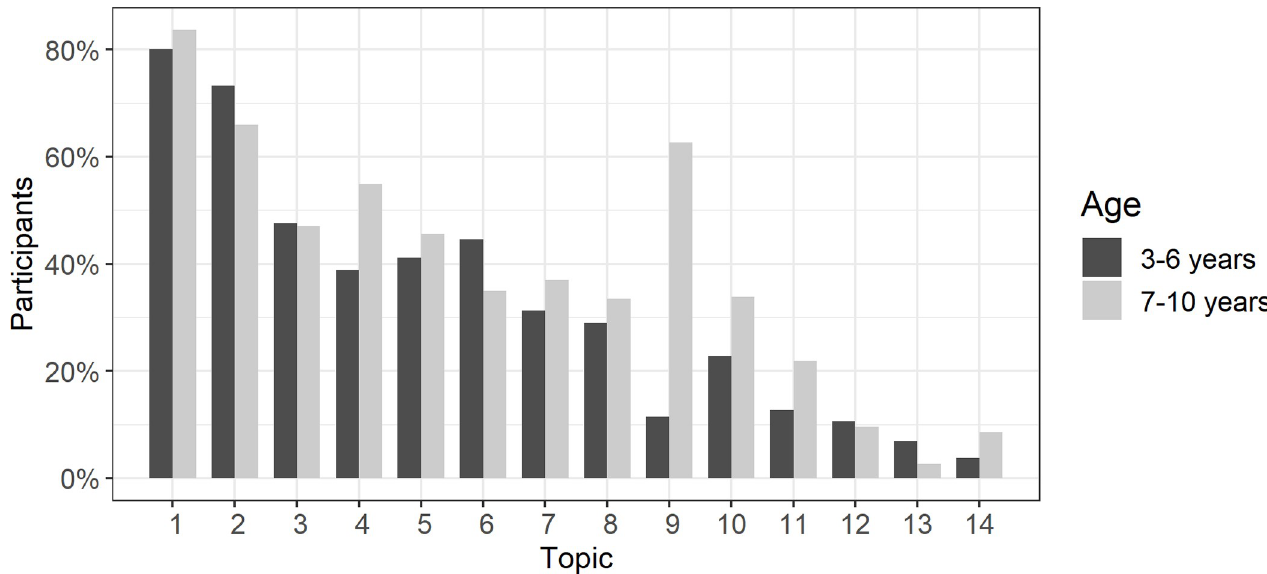
Fig 2. Reasons for the child being stressed, irritated or sad split by the child’s age. Topics: 1) Child cannot meet its friends regularly. 2) Child cannot meet other family members (e.g., grandparents). 3) Child is bored. 4) Child cannot engage in hobbies/sports. 5) Conflicts about media usage (e.g., mobile phone, computer, tablet). 6) Me or my partner are more irritable than usual and sometimes overreact. 7) More disputes with siblings. 8) Child cannot leave the apartment/house as he/she wants to. 9) Conflicts about doing schoolwork or other duties. 10) Conflicts about keeping a daily routine. 11) Concern that other people might get sick. 12) Child is constantly surrounded by one parent at home. 13) Others. 14) Concern about getting sick oneself.